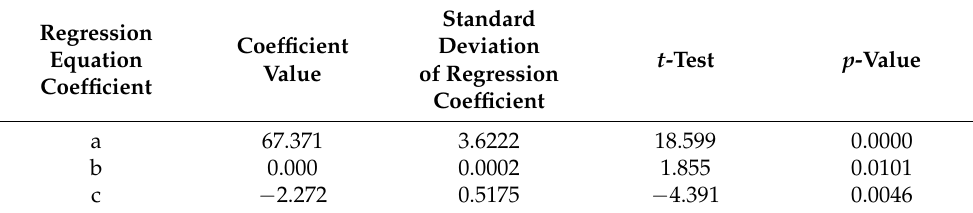
Table 1. Parameters of regression equation *.